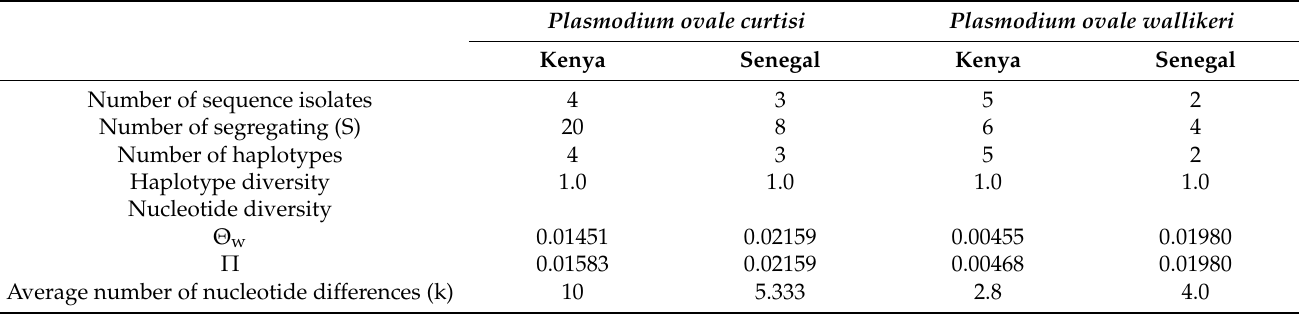
Table 3. Genetic diversity of Po curtisi and Po wallikeri in Kenya and Senegal using the tryptophan-rich antigen